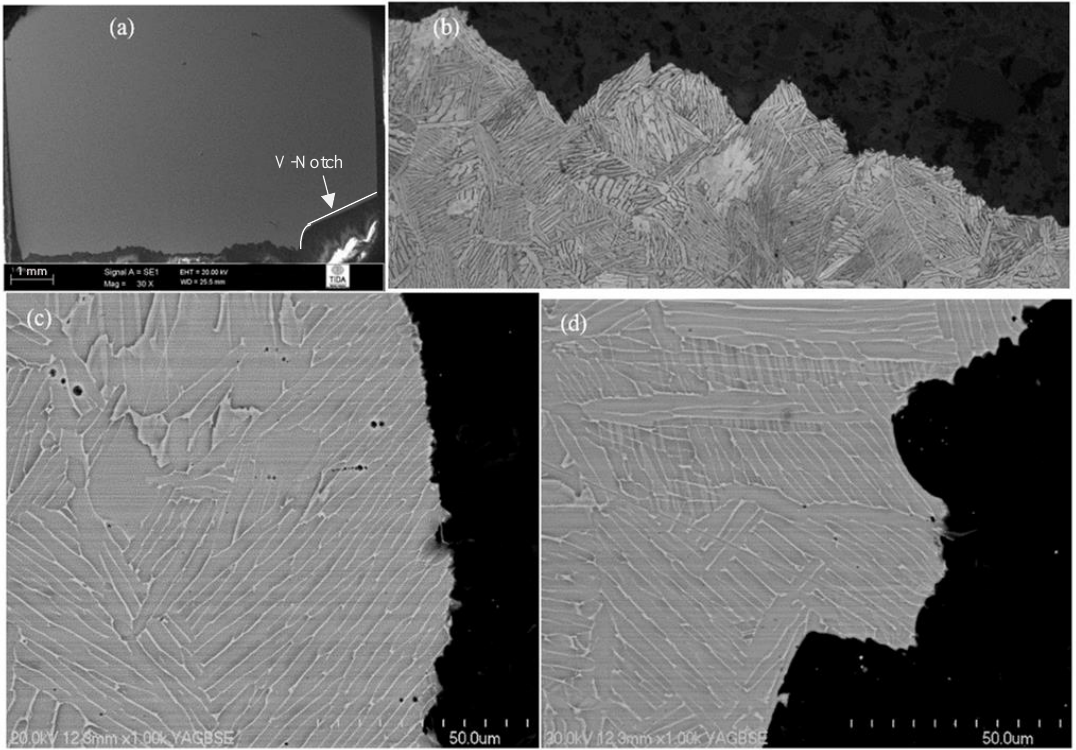
Figure 6. Crack propagation behaviour of 955 ◦ C / 1 h, FC heat-treated material: ( a ) overall crack path; ( b ) transgranular fracture; ( c , d ) individual α lamellar plates and retained β phase matrix providing sufficient hindering to crack growth.